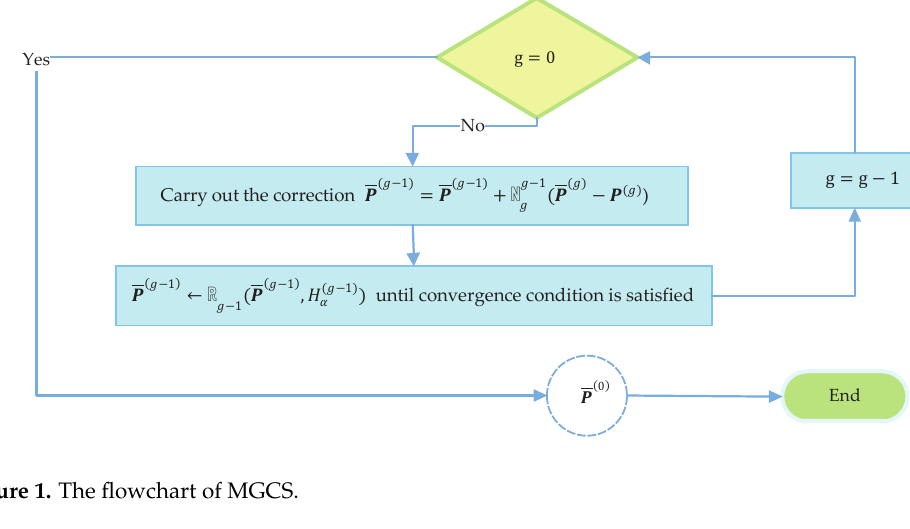
Figure 1. The flowchart of MGCS.